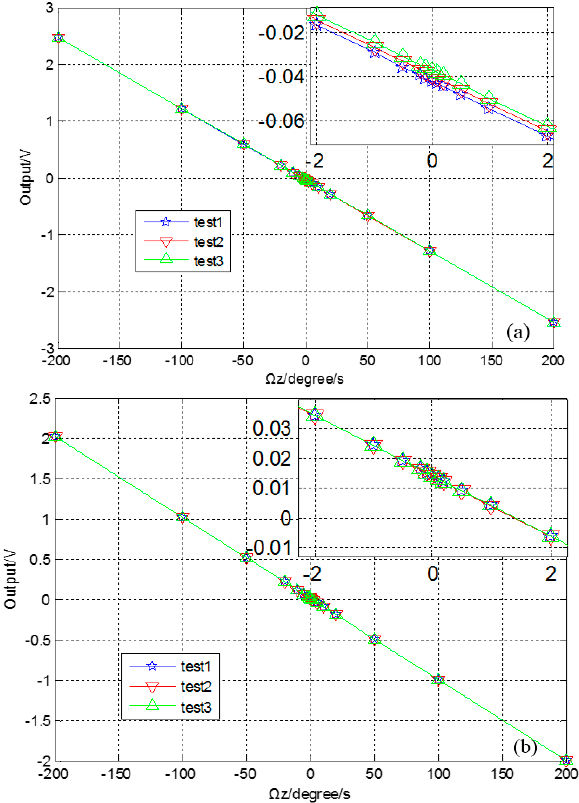
Figure 18. Scale factor test, without quadrature error correction ( a ) and CSC method ( b ). Table 2. Test summary.